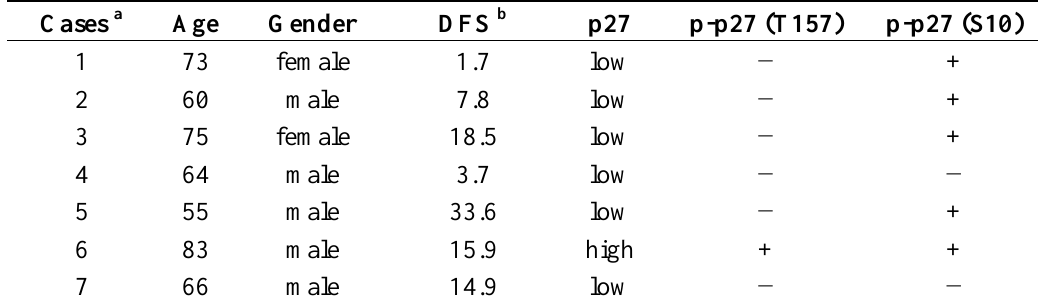
Table 5. Expression profiles of p27 and phosphor-p27 in the cases with less than three years of disease-free